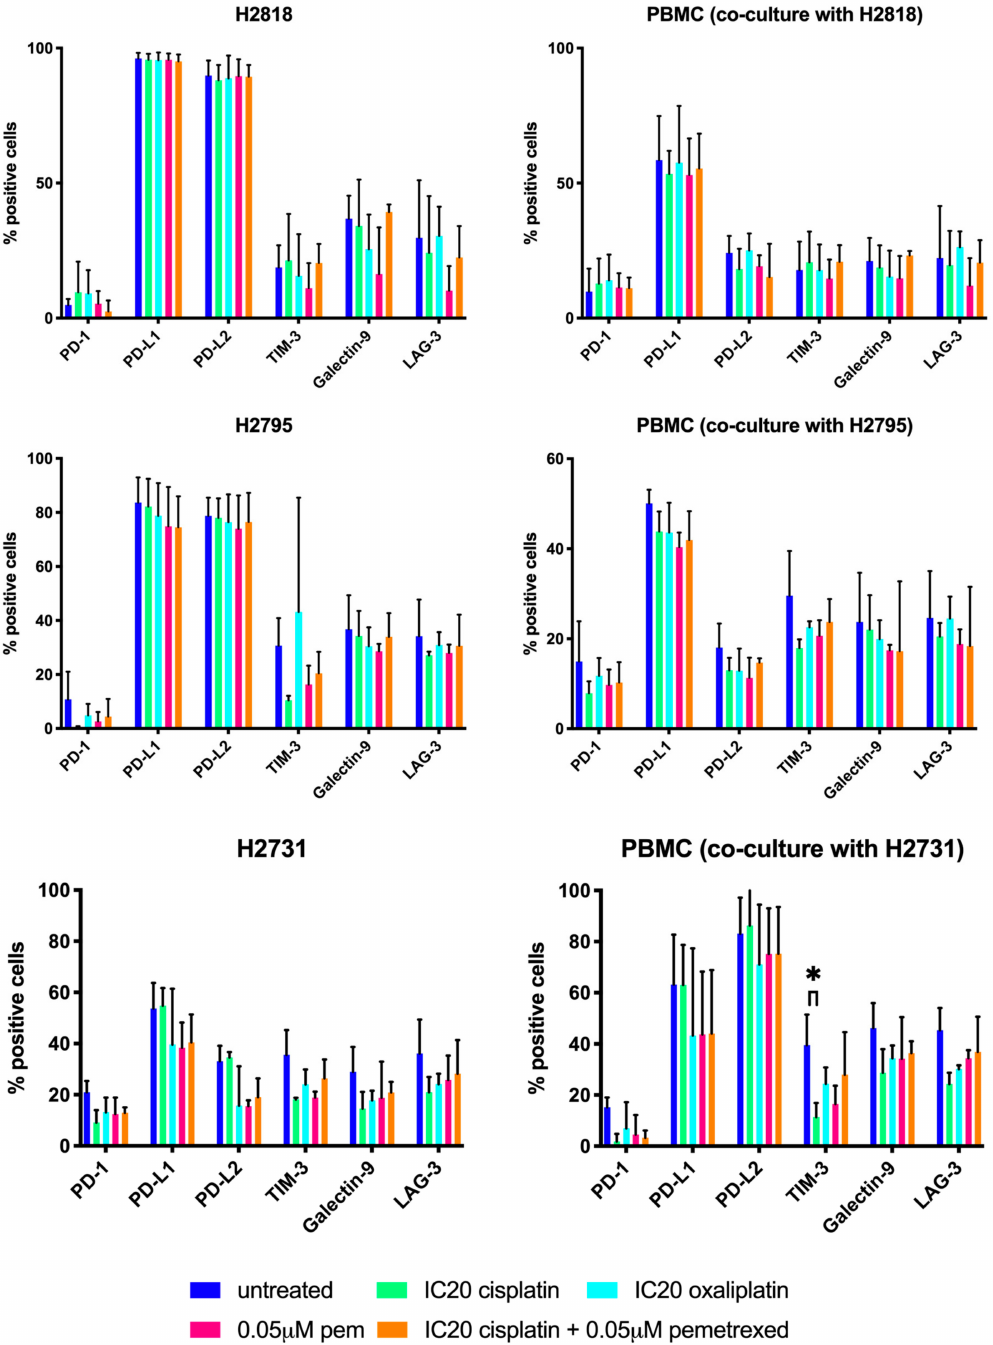
Figure 3. Influence of chemotherapeutics on immune checkpoint expression on MPM cell lines and PBMC in co-culture (overton percentages). Bar charts of mean overton percentages representing the percentages of NCI-H2818, NCI-H2795, NCI-H2731 and corresponding PBMC that express the immune checkpoints or ligands. Following chemotherapy. Error bars represent the standard deviation ( n = 3). * p < 0.05: significant di ff erence in % of cells expressing immune checkpoints or ligands * p < 0.05: significant di ff erence in immune checkpoint expression. Isotype controls were used to consider aspecific binding of the flow cytometry